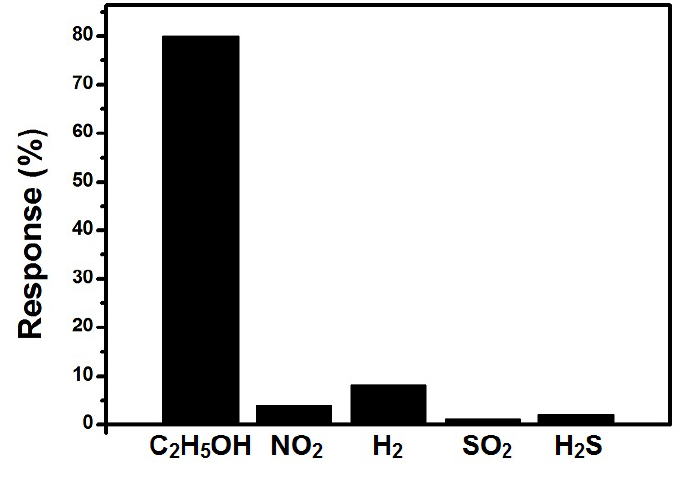
Figure 11. Response of the SnO and H 2